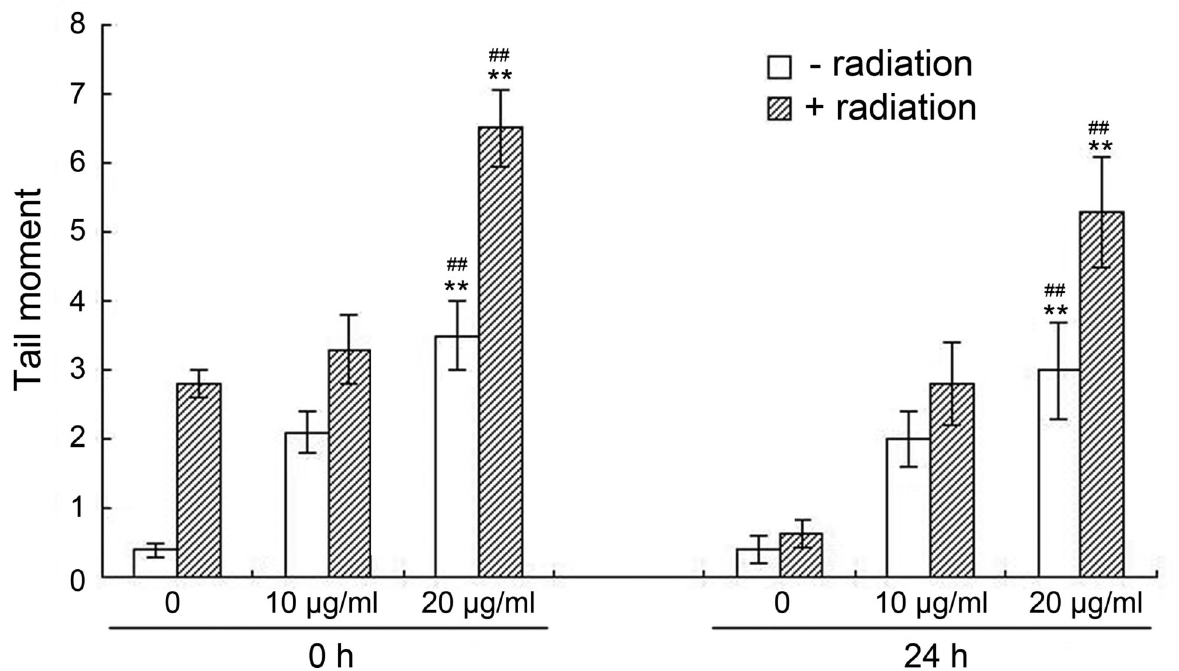
Figure 3 - Influence of elemene on radiation-induced DSB. A549 cells were irradiated with 4 Gy X-rays in the absence or presence of elemene (10 or 20 m g/mL) and assayed immediately after radiation or returned to the incubator for 24 h to permit repair. Comet assays were performed immediately after incubation with elemene treatment, irradiation, or combination treatment. Columns represent the means of the tail moments from three independent experiments, and the bars represent the SD, ** p o 0.01 vs. control, ## p o 0.01 compared to radiation